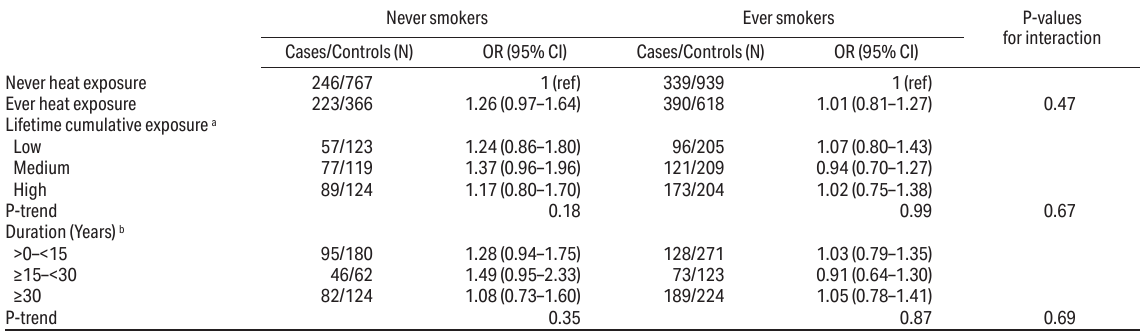
Table 4. Associations between occupational heat exposure and colorectal cancer stratified by cigarette smoking. [OR=odds ratio; CI=confidence interval]. All models are adjusted for age, sex, region, education, family history of colorectal cancer, BMI and occupational physical